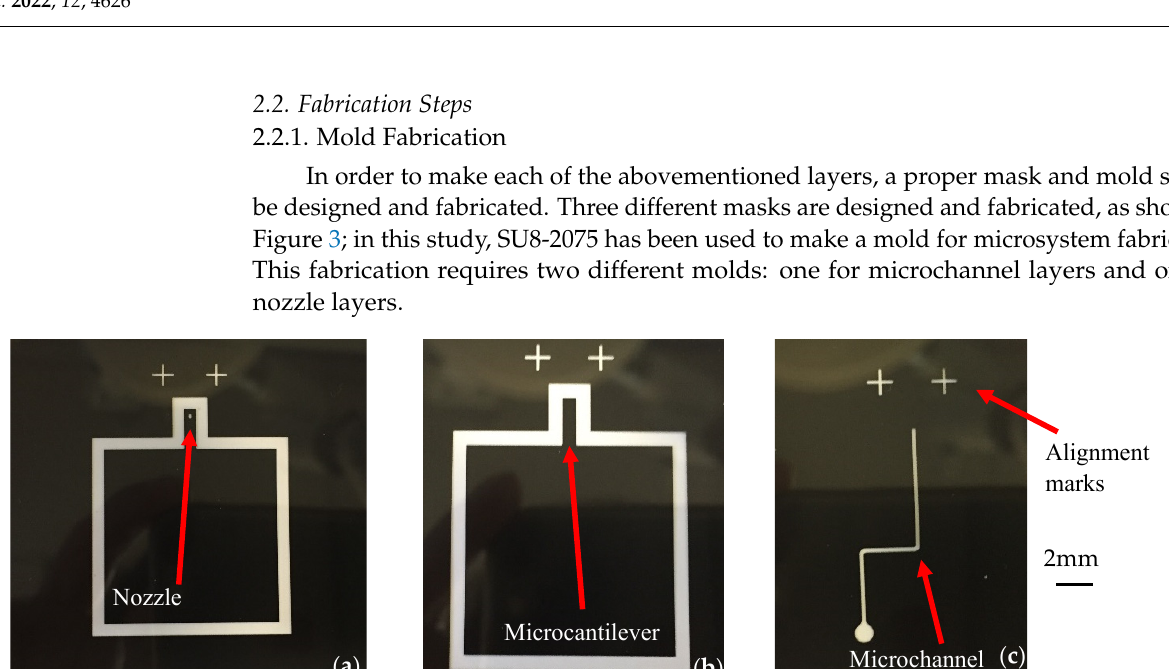
Figure 5. The PDMS layers fabrication processes a) Pouring PDMS on the mold b) Applying pressure using grippers c) PDMS layer after curing process d) Detaching PDMS layer from mold .